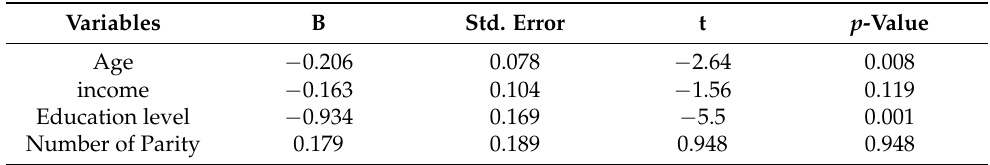
Table 3. Results of FA intake during the first three months of pregnancy with some demographic features of women using regression